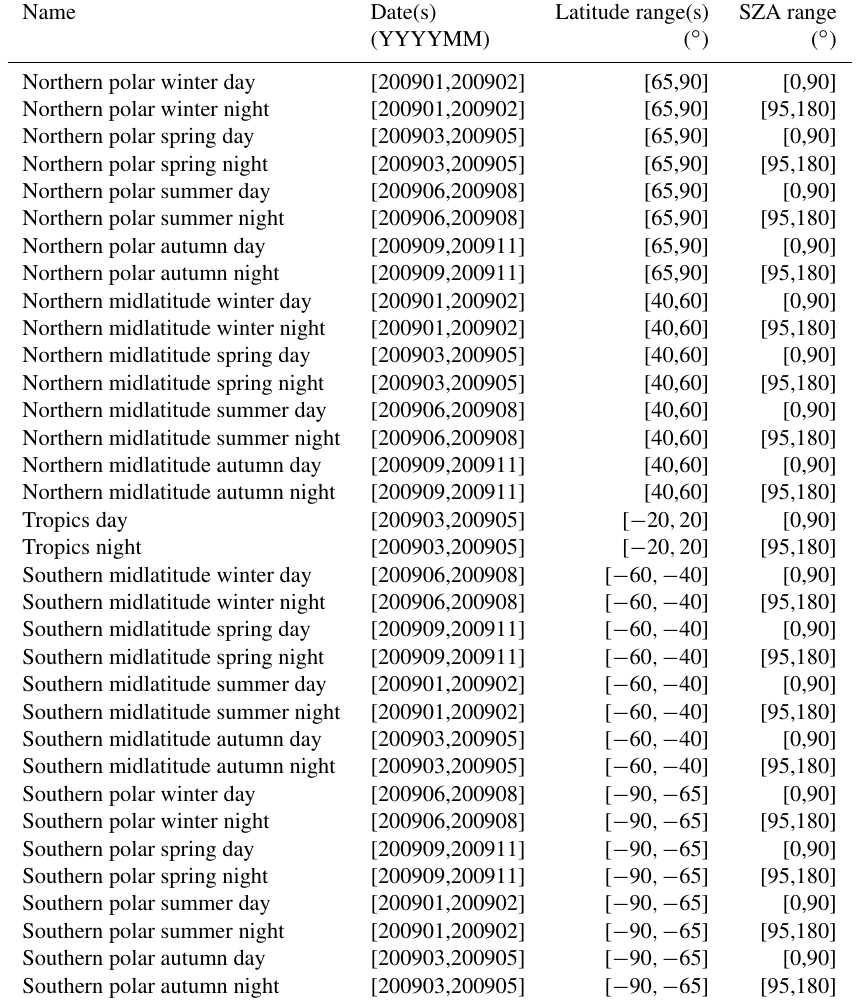
Table A2. Measurements used for error analysis of RR nominal